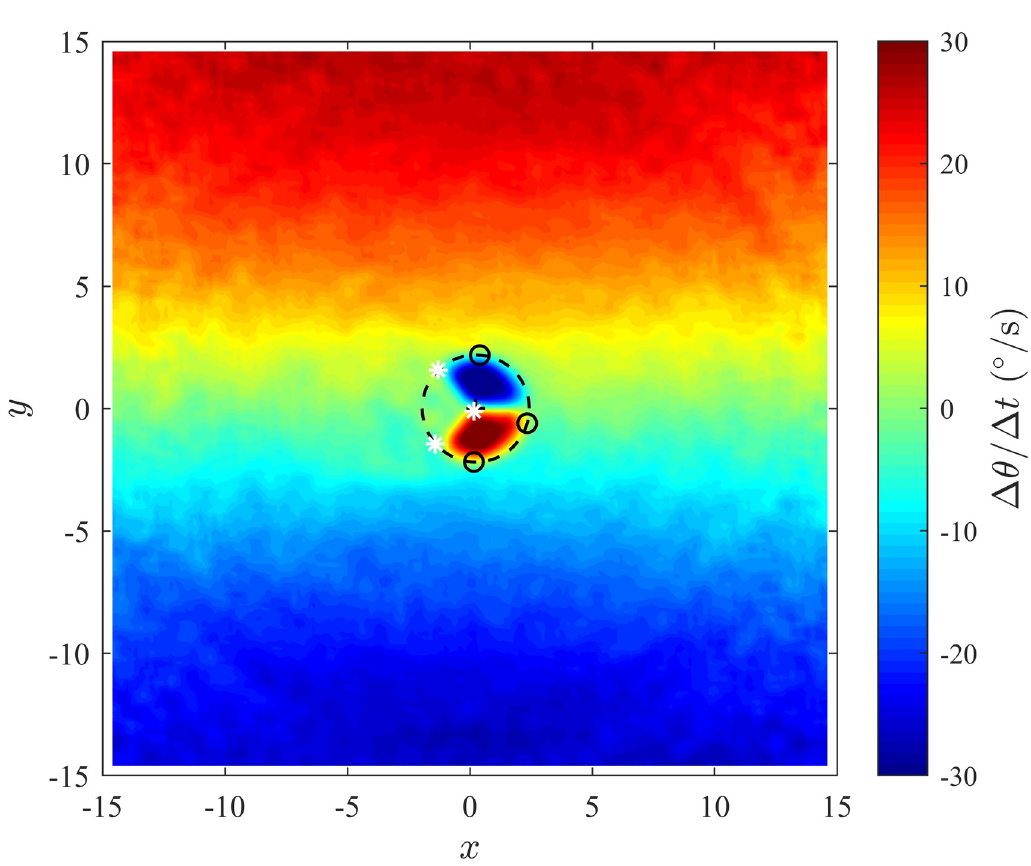
Fig 2. Changes in direction as a function of the relative coordinates of partners in groups with emergent cohesion behaviour where ω = 90˚, r = 2, Δ r = 1 and Δ r = 11. Small black circle represents the points used to fit the circle estimating the ZOR. blind r o a The white asterisks represent the points that were used to estimate the size of the blind angle. (Derived from simulations with N = 25 individuals over 1000 time steps).